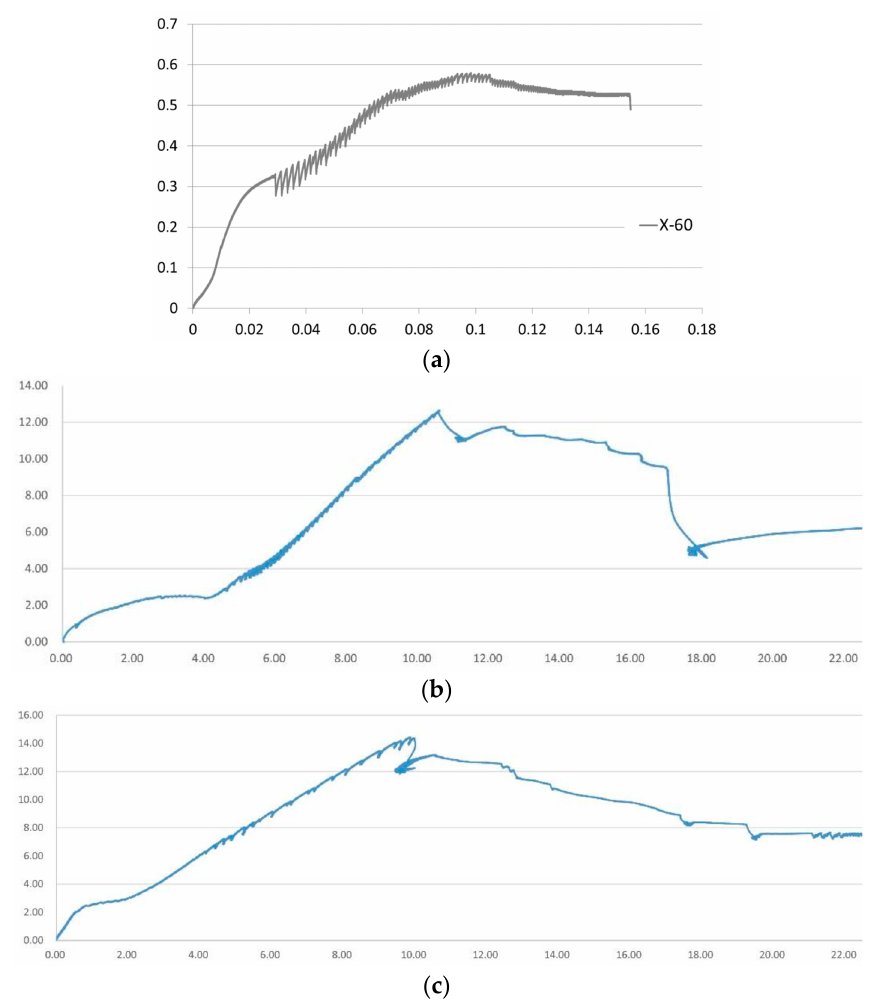
Figure 12. The divergent layouts of some curves: ( a ) specimen No. 1. ( b ) specimen No. 11. ( c ) spec- imen No. 13. No.